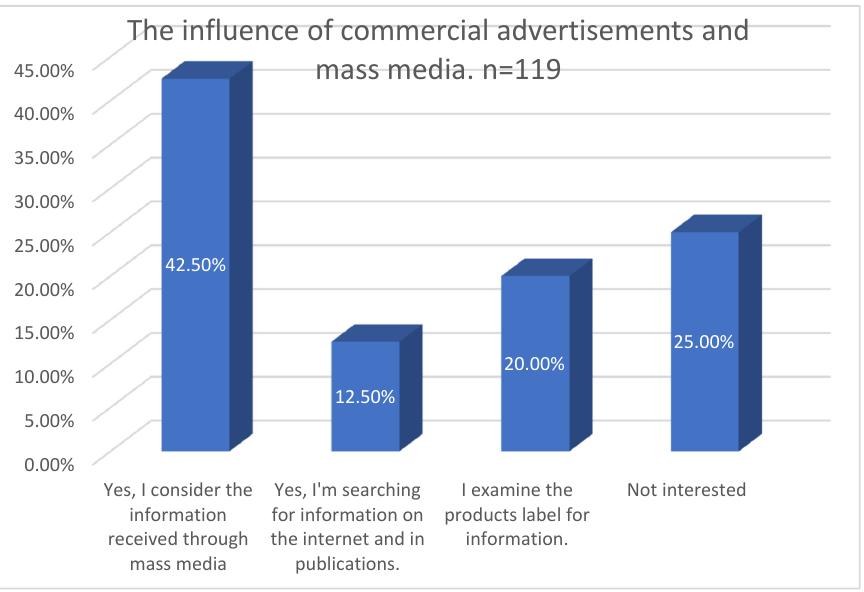
Figure 7. The influence of commercial advertisements and mass media.